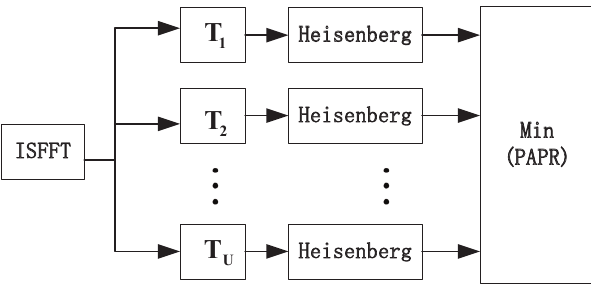
Figure 3. Flowchart of